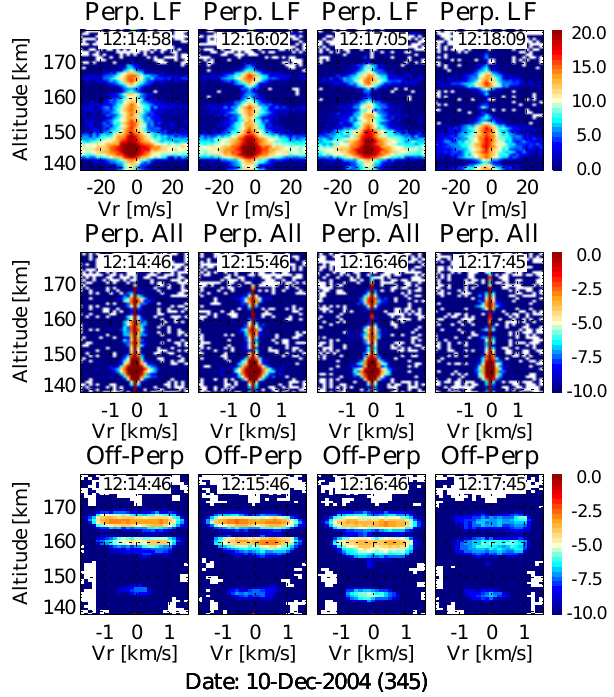
Fig. 3. Sample spectrograms for the signals used in Fig. 2 for four consecutive minutes. Each spectrogram has been averaged for 1min. To display the spectrogram of the off-perpendicular signal, we have used a 3-point median filter. The color code for the signal intensity is displayed to the right of each